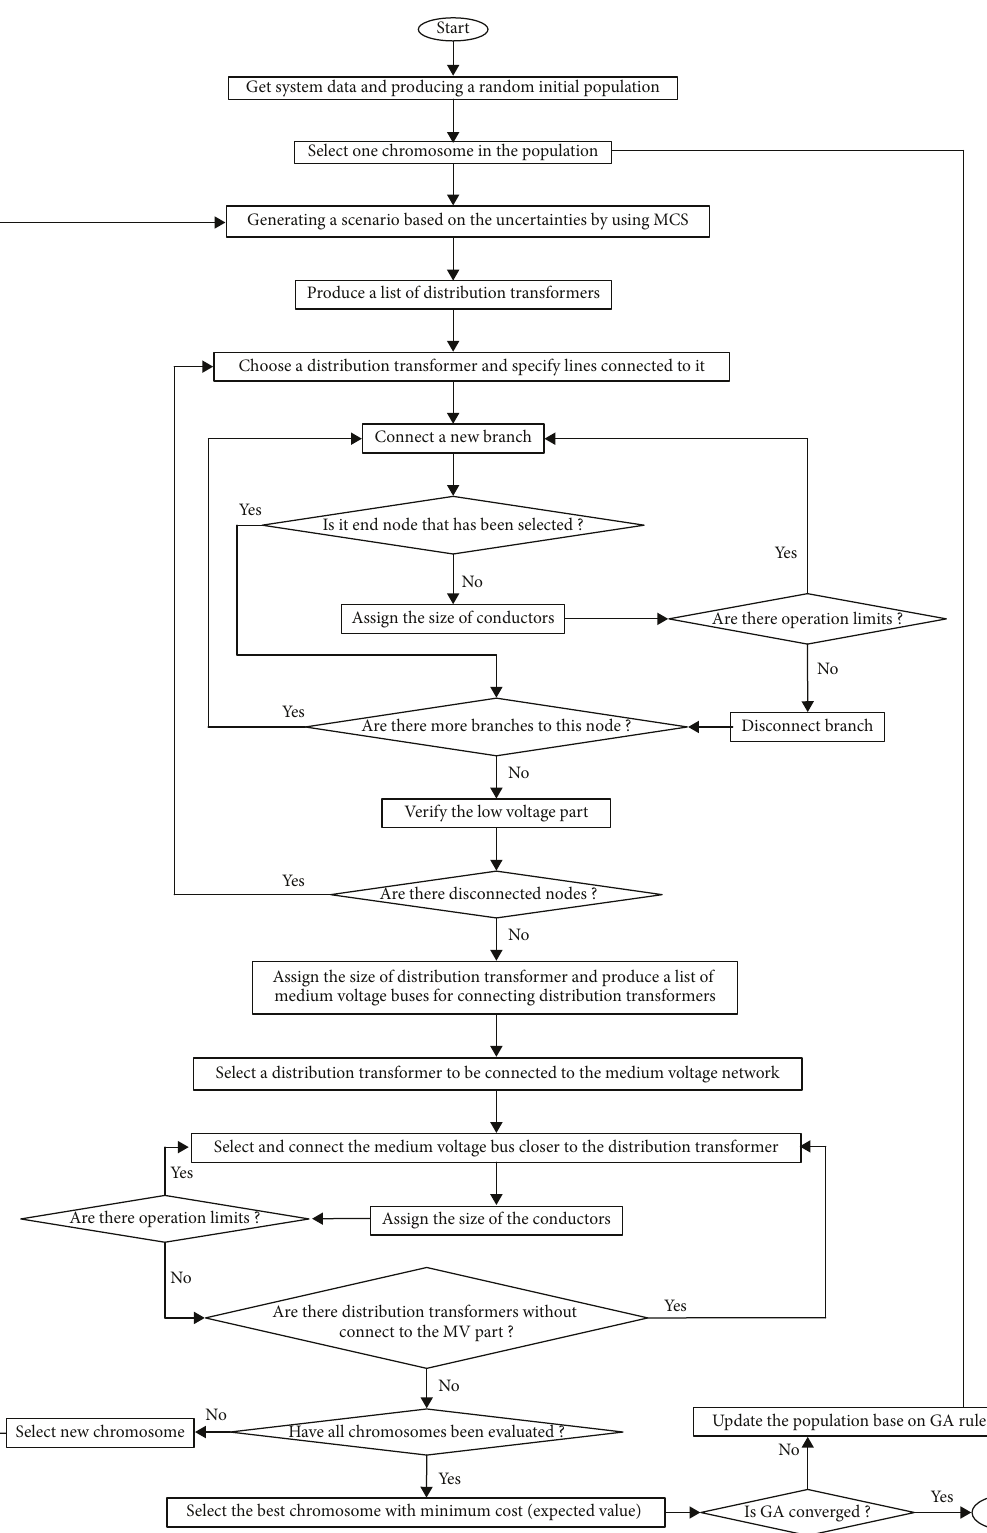
Figure 5: Flowchart of the proposed